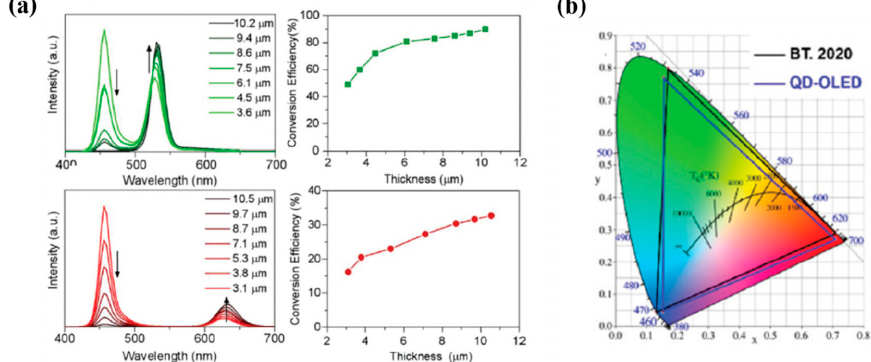
Figure 3. ( a ) Photoluminescence (PL) spectra and light conversion efficiency (LCE) of green and red QD layers at different thicknesses. ( b ) Color gamut of the QD-OLED display (blue triangle area), in comparison with the color gamut of BT. 2020 (black triangle area) [47]. Figure reproduced with permission from Royal Society of Chemistry.